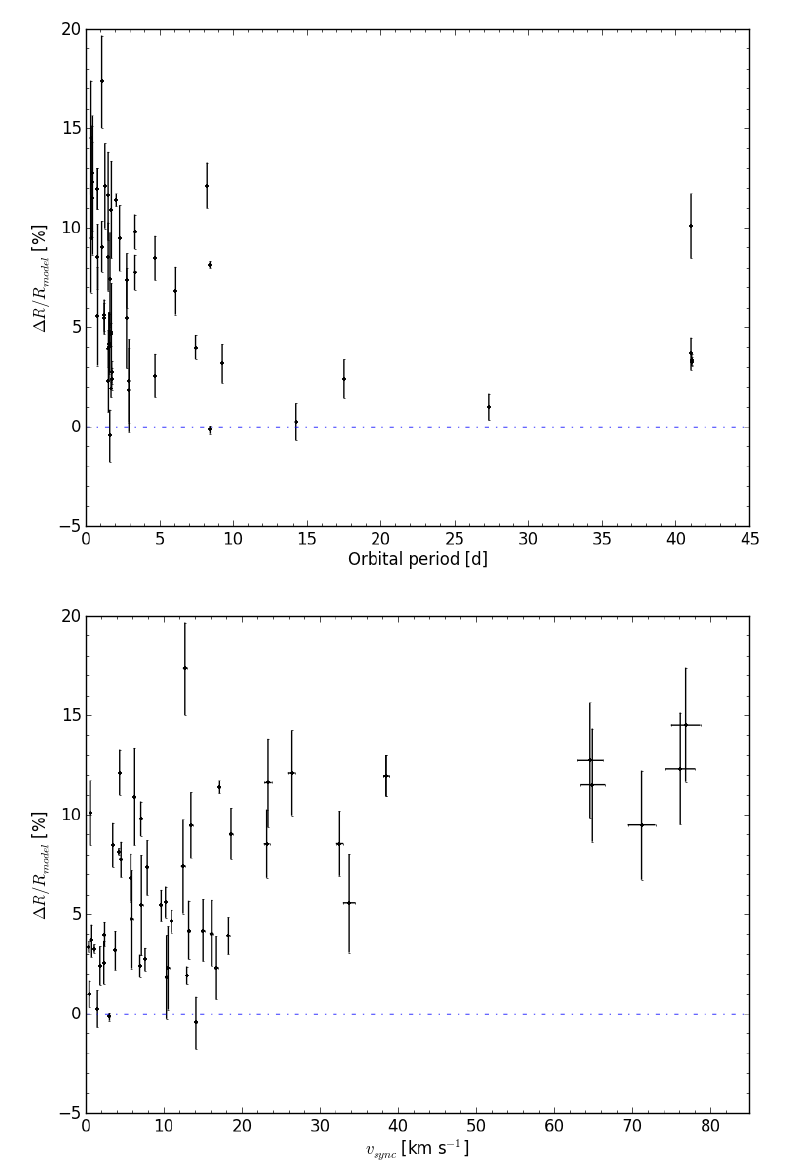
Figure 4. Relative radius difference with respect to the BHAC15 stellar models at 1Ga as a function of the orbital period of the system ( top ) and the pseudo-synchronization rotation velocity at periastron ( bottom ). The horizontal blue dot-dashed line is shown as a reference of agreement with the BHAC15 1Ga